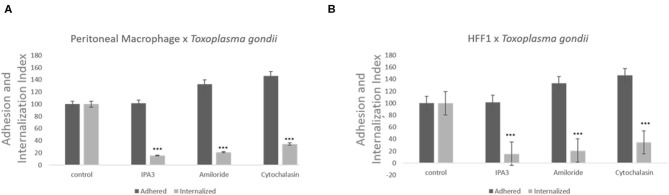
Inhibitors against the macropinocytosis pathway, such as those against Na+/H+ exchangers and PAK1, promote a significant decrease in T. gondii invasion. Macrophages (A) and HFF1 cells (B) previously treated with IPA3 (5 μM), amiloride (100 μM), and cytochalasin D (100 nM), for 60 min, washed with PBS (three times) and then infected with T. gondii (30 min), as described in the Materials and Methods. Note that after all treatments there is a significant reduction of entry into both cell types when compared with control (*** indicates significant difference in relation to the control with value of p < 0.05).